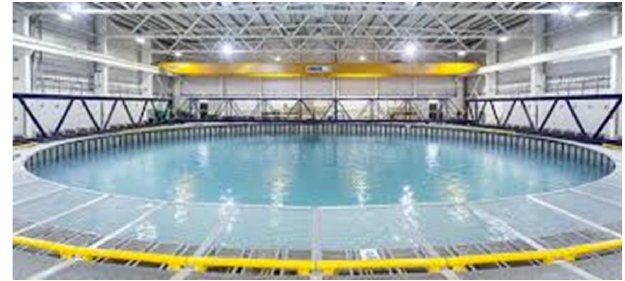
Fig. 5. The FloWave wave tank [8].